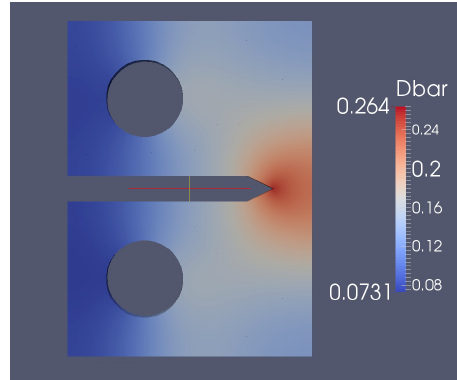
Figure 4. Mesh generation.